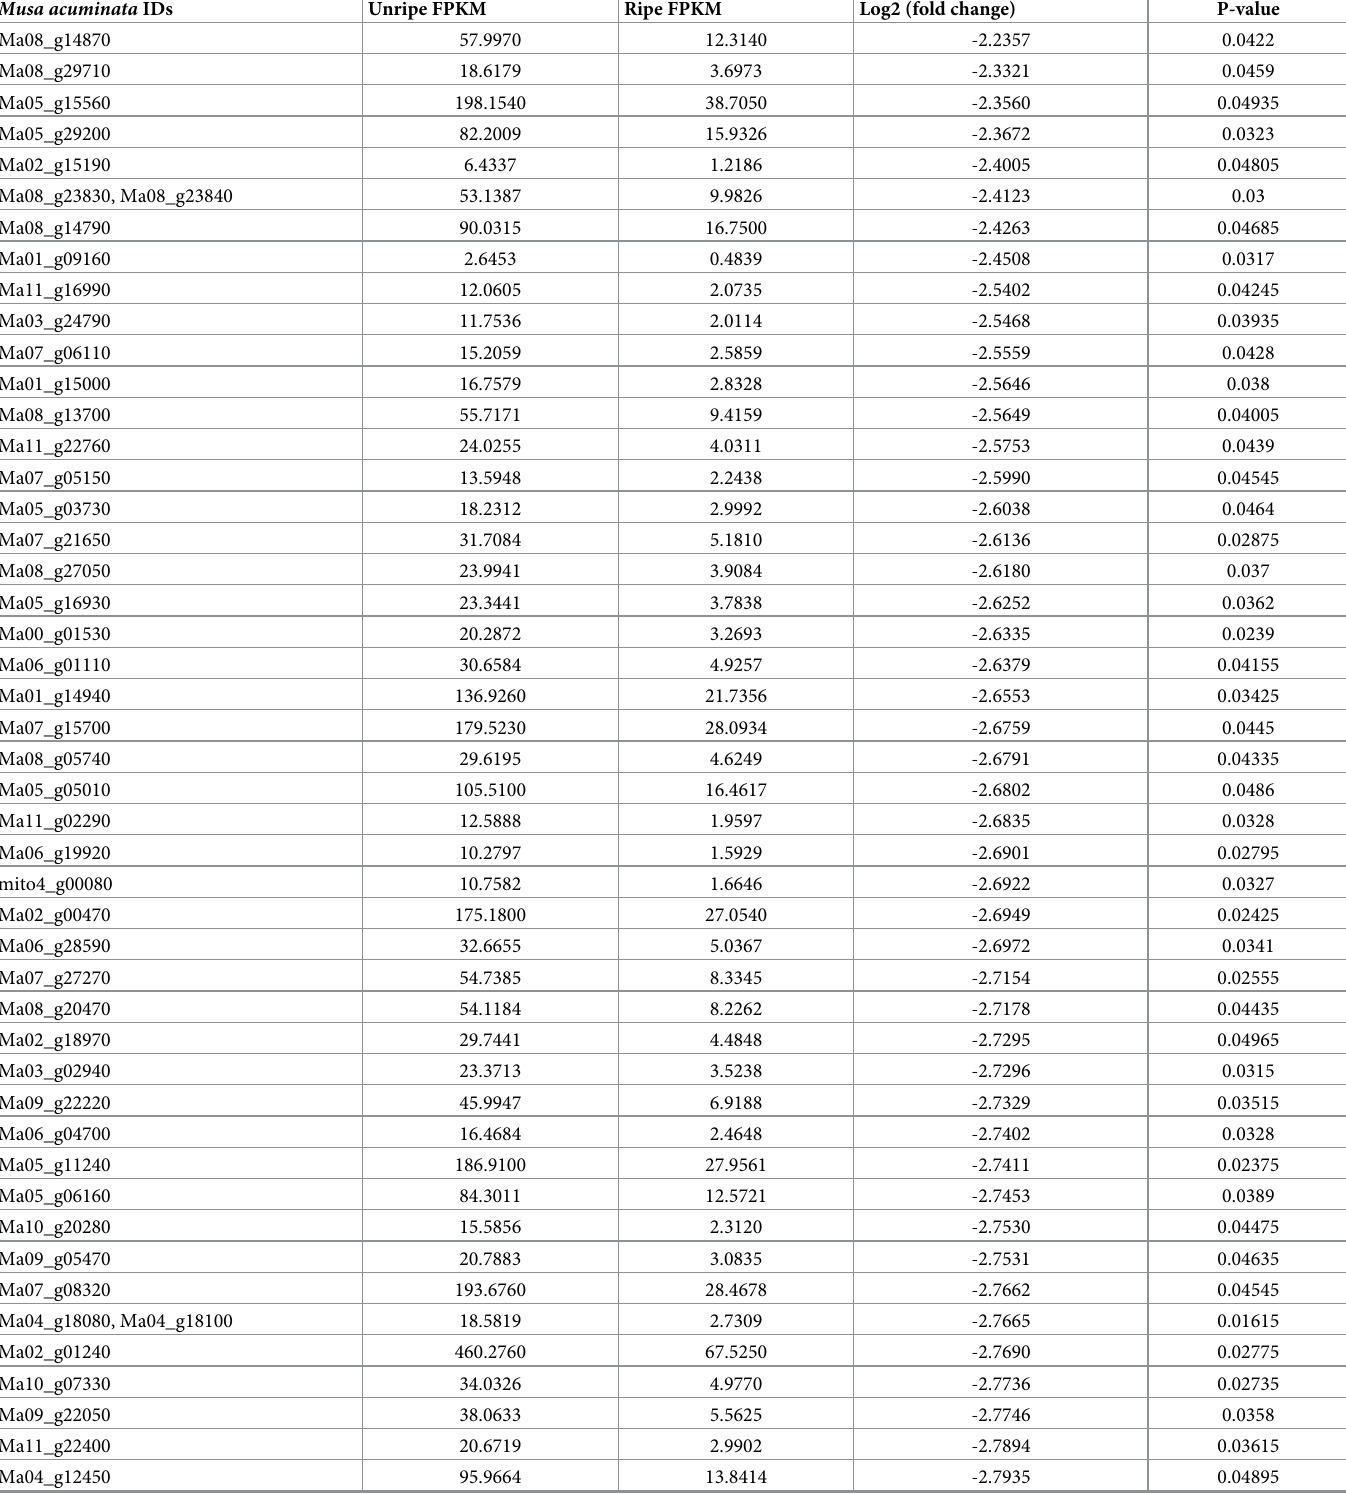
Table 3. List of top 50 down-regulated genes in Nendran ripe fruit samples. Musa acuminata